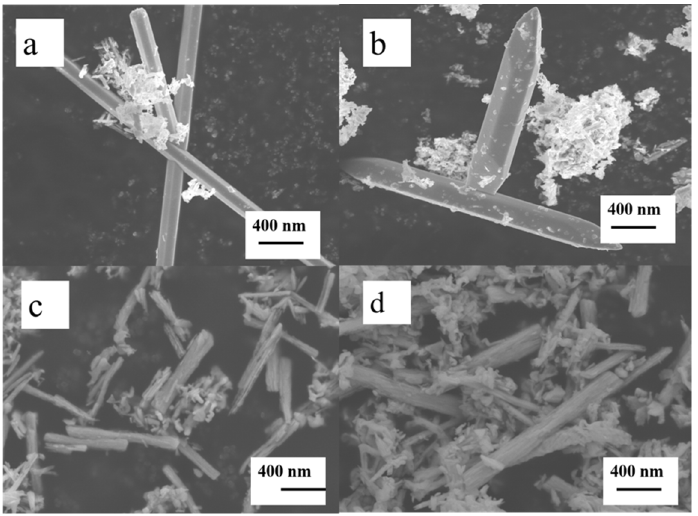
Figure 2. FESEM images of ( a ) pure Bi 2 Te 3 , ( b ) Bi 2 Te 3 /Bi core-shell, and ( c , d ) Bi 2 Te 3 /AgBiTe 2 heterostructure.